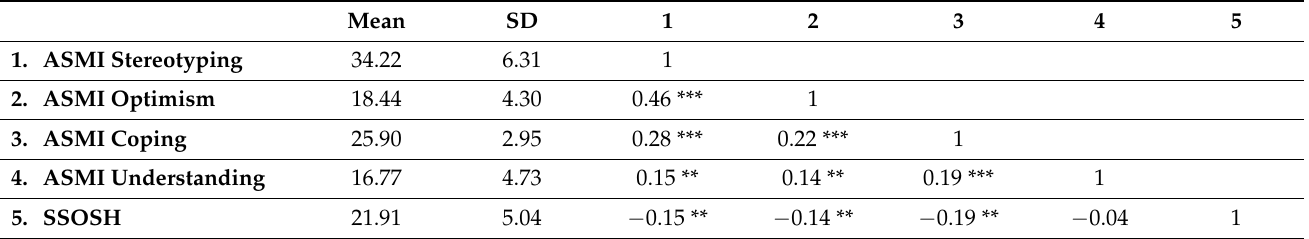
Table 3. Means, standard deviations, and inter-correlations between the study variables. Mean SD